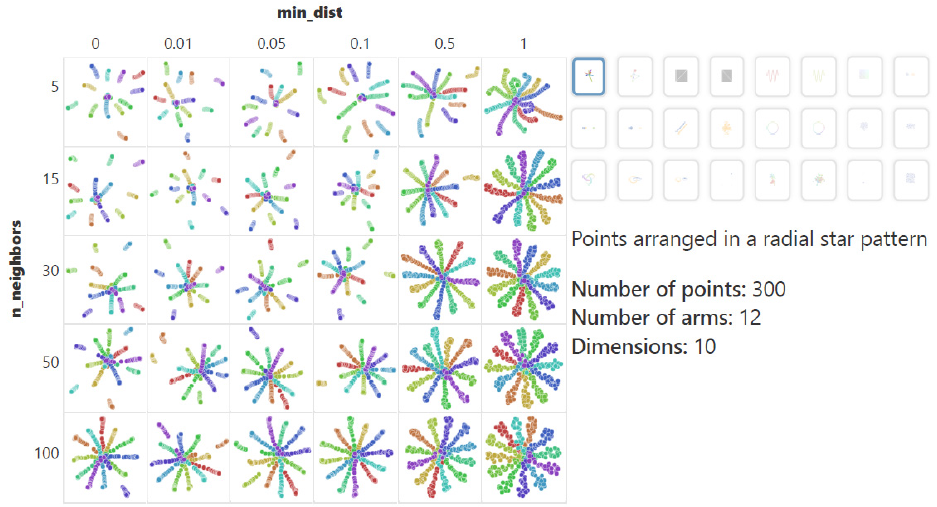
Figure 7. UMAP projection of various toy datasets with a variety of common values for the n_neighbors and min_dist parameters. Adapted from [16], original source code available in https://github.com/PAIR-code/understanding-umap.